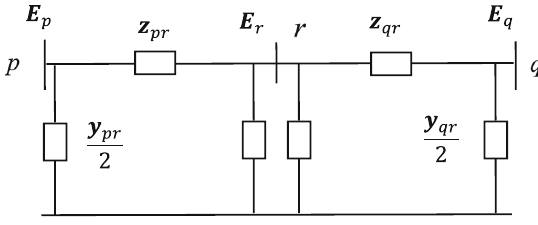
Fig. 1 A segment of a transmission